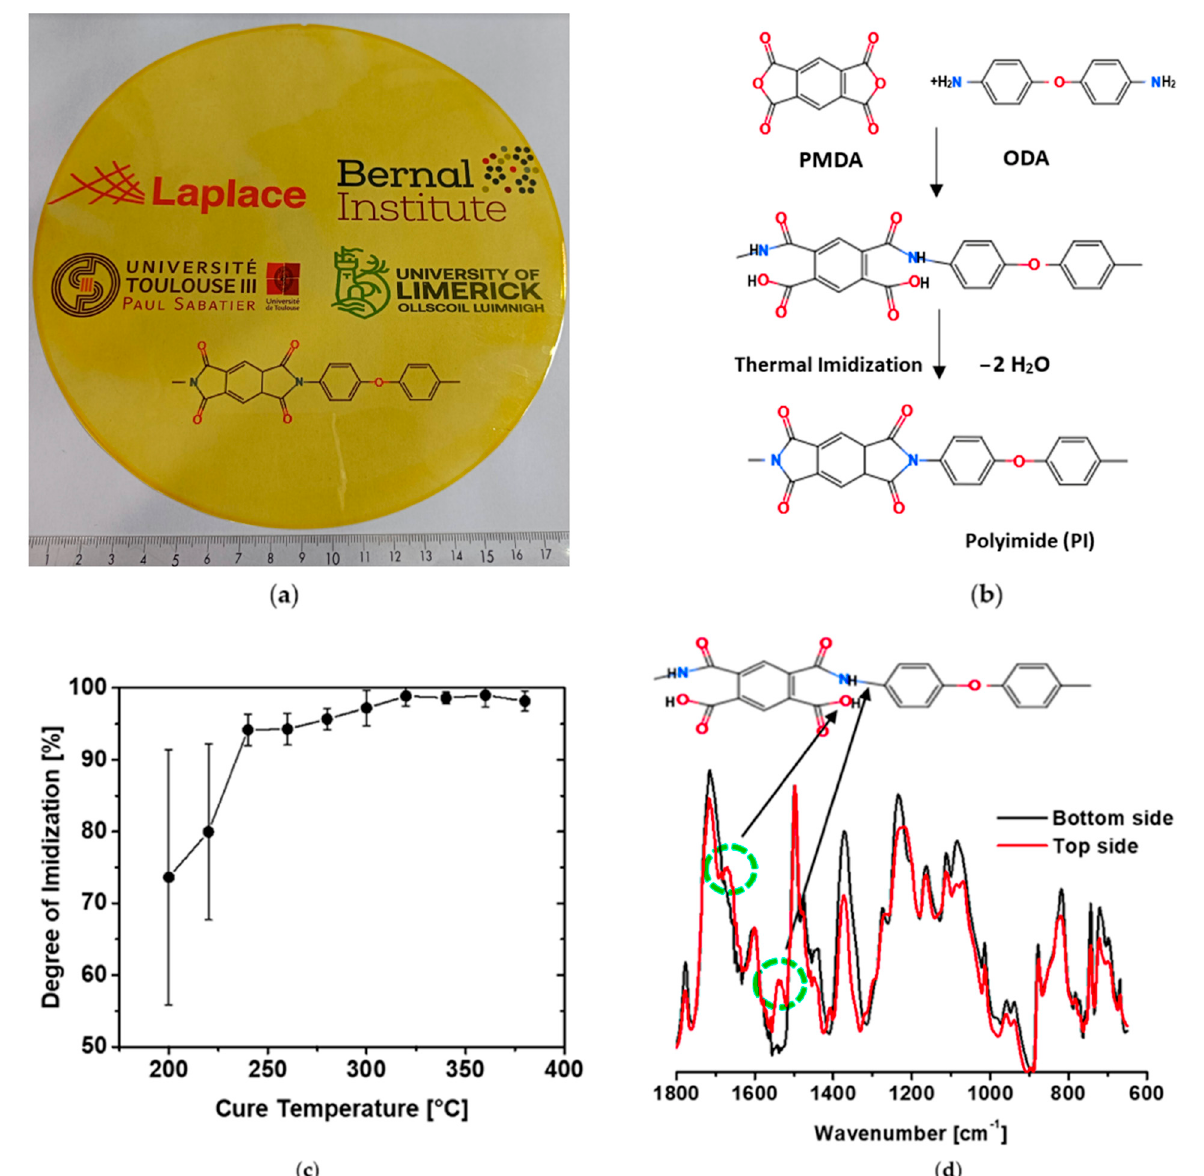
Figure 1. ( a ) Polyimide film peeled-off from an 8-inch wafer cured at 240 °C. ( b ) Synthesis steps of the PMDA/ODA PI. ( c ) Effect of curing temperature on the degree of imidization. ( d ) ATR-FTIR spectra for PI films cured at 200 °C (top and bottom sides).